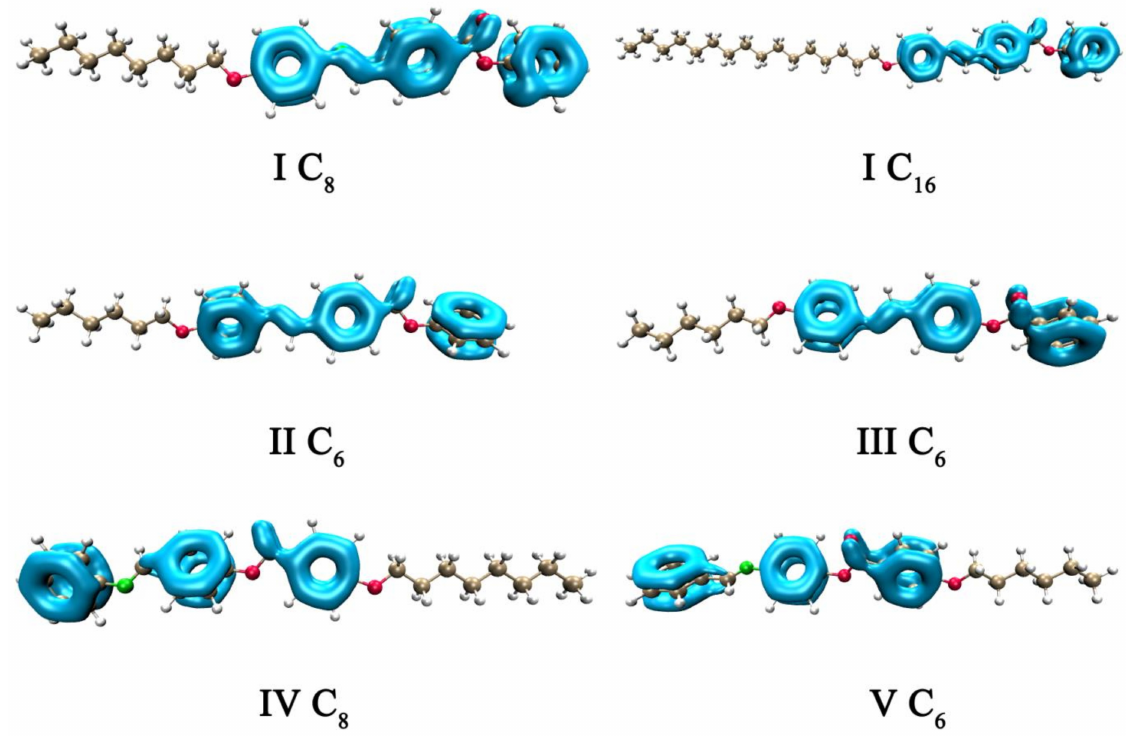
Figure 13. Isosurface maps of LOL- π (Isovalue = 0.3) of compounds I C 8 , I C 16 , II C 6 , III C 6 , IV C 8 , and V C 6